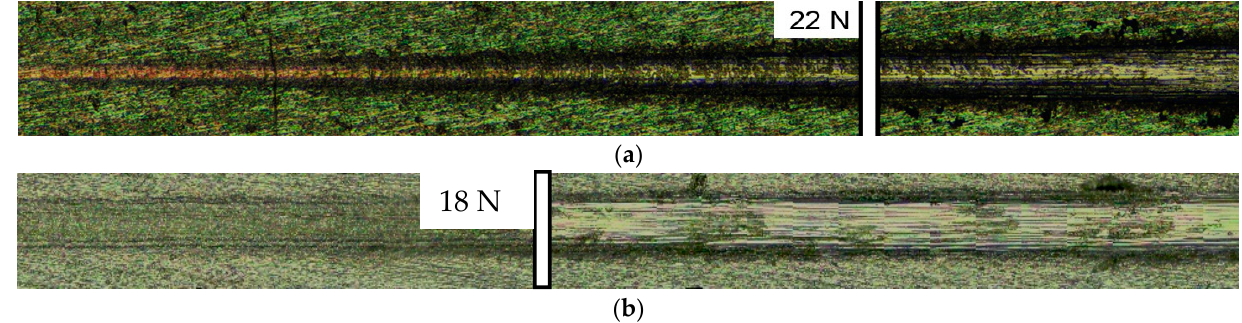
Figure 15. Indentation track from the indenter after the adhesion test by the scratch test of CaP coating on NS Ti substrate ( a ) and CG Ti substrate ( b ).